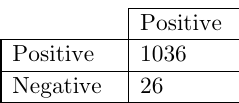
Table 2. Confusion matrix depicting the bite detection performance of EXI using the EaC dataset. N/A (i.e., Not Available) is used to indicate TN cannot be calculated using the adopted evaluation scheme 47 ; this is depicted in Fig. 5. The total number of true bites in EaC is 1062 (sum of TP and FN). Given the confusion matrix, the performance metrics precision/recall/F1 are calculated to be 0.929/0.975/0.952.